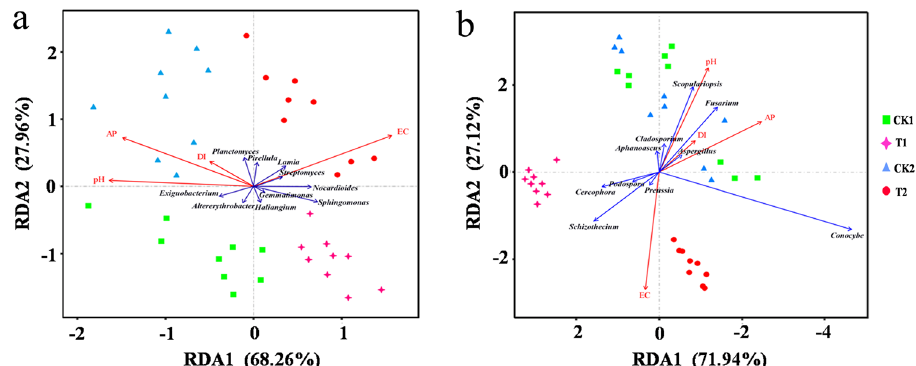
Figure 5. Plots of redundancy analysis (RDA) ordination displaying the interactions between the top 10 bacterial ( a ) and fungal genera ( b ) and soil environmental variables. AP denotes available phosphorus; pH denotes the solar pH; EC denotes electrolyte conductivity; the disease index (DI) denotes healthy plants as “0”and Fusarium wilt plants as “1”. CK1 represents the soil without wheat straw addition at the watermelon flowering stage while T1 represents the soil with wheat straw addition at the watermelon flowering stage; CK2 represents the soil without wheat straw addition at the watermelon fruiting stage and T2 represents the soil with wheat straw addition at the watermelon fruiting